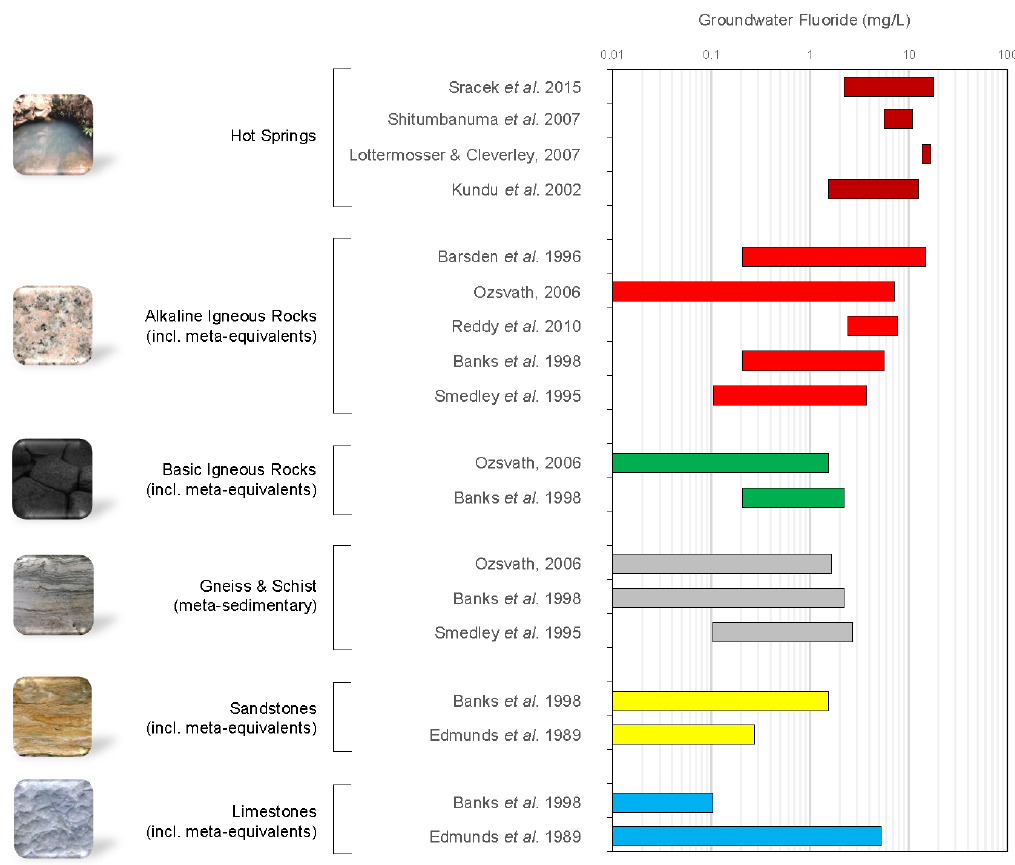
Figure 1. Summary of global data for groundwater fluoride concentration ranges and geogenic source. Hot springs represent deep hydrothermal groundwater fluoride source, all others represent shallow rock weathering groundwater fluoride source, sorted per lithology type (References for data: [10,27–35]; hot spring photo source: [36]).